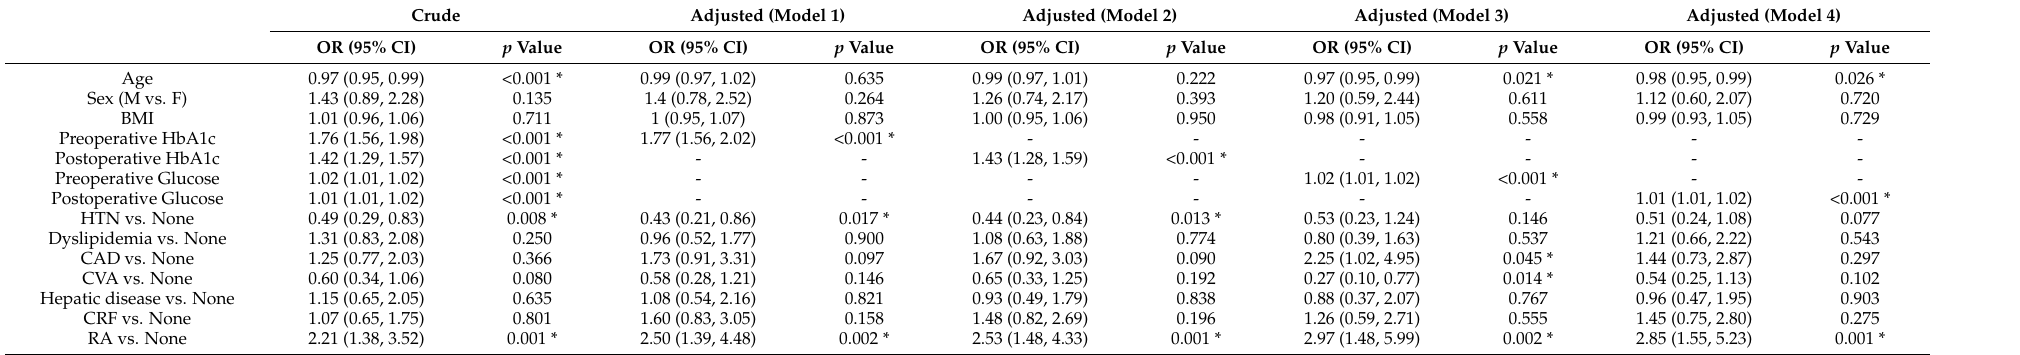
Table 3. Factors associated with postoperative surgical site